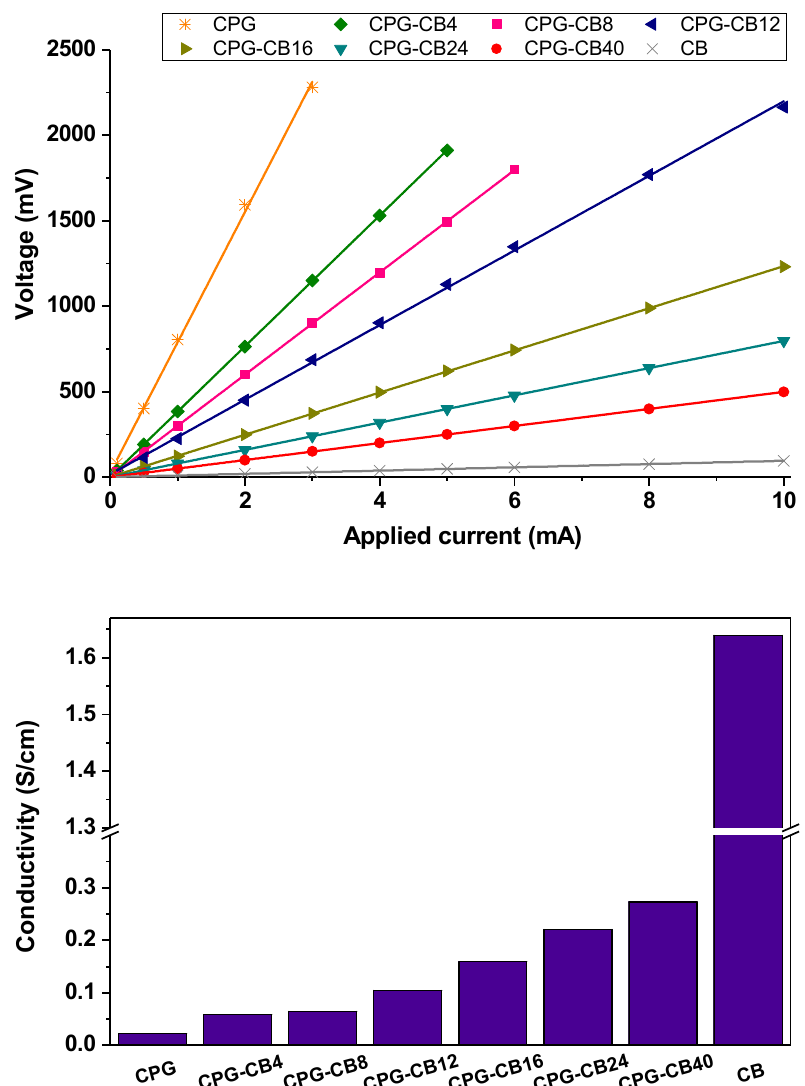
Figure 5. ( Top ) U–I curves and ( bottom ) electrical conductivity values for the studied carbon gel/CB composites.